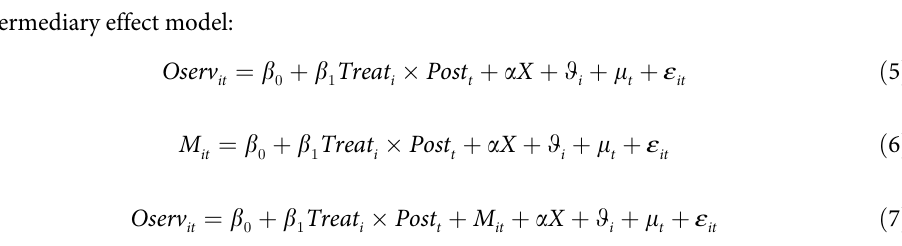
is: − 0.737 × Size+0.043 × Size 2 − 0.04 × Age . columns (1)-column (3) show that the accelerated depreciation policy of fixed assets increases